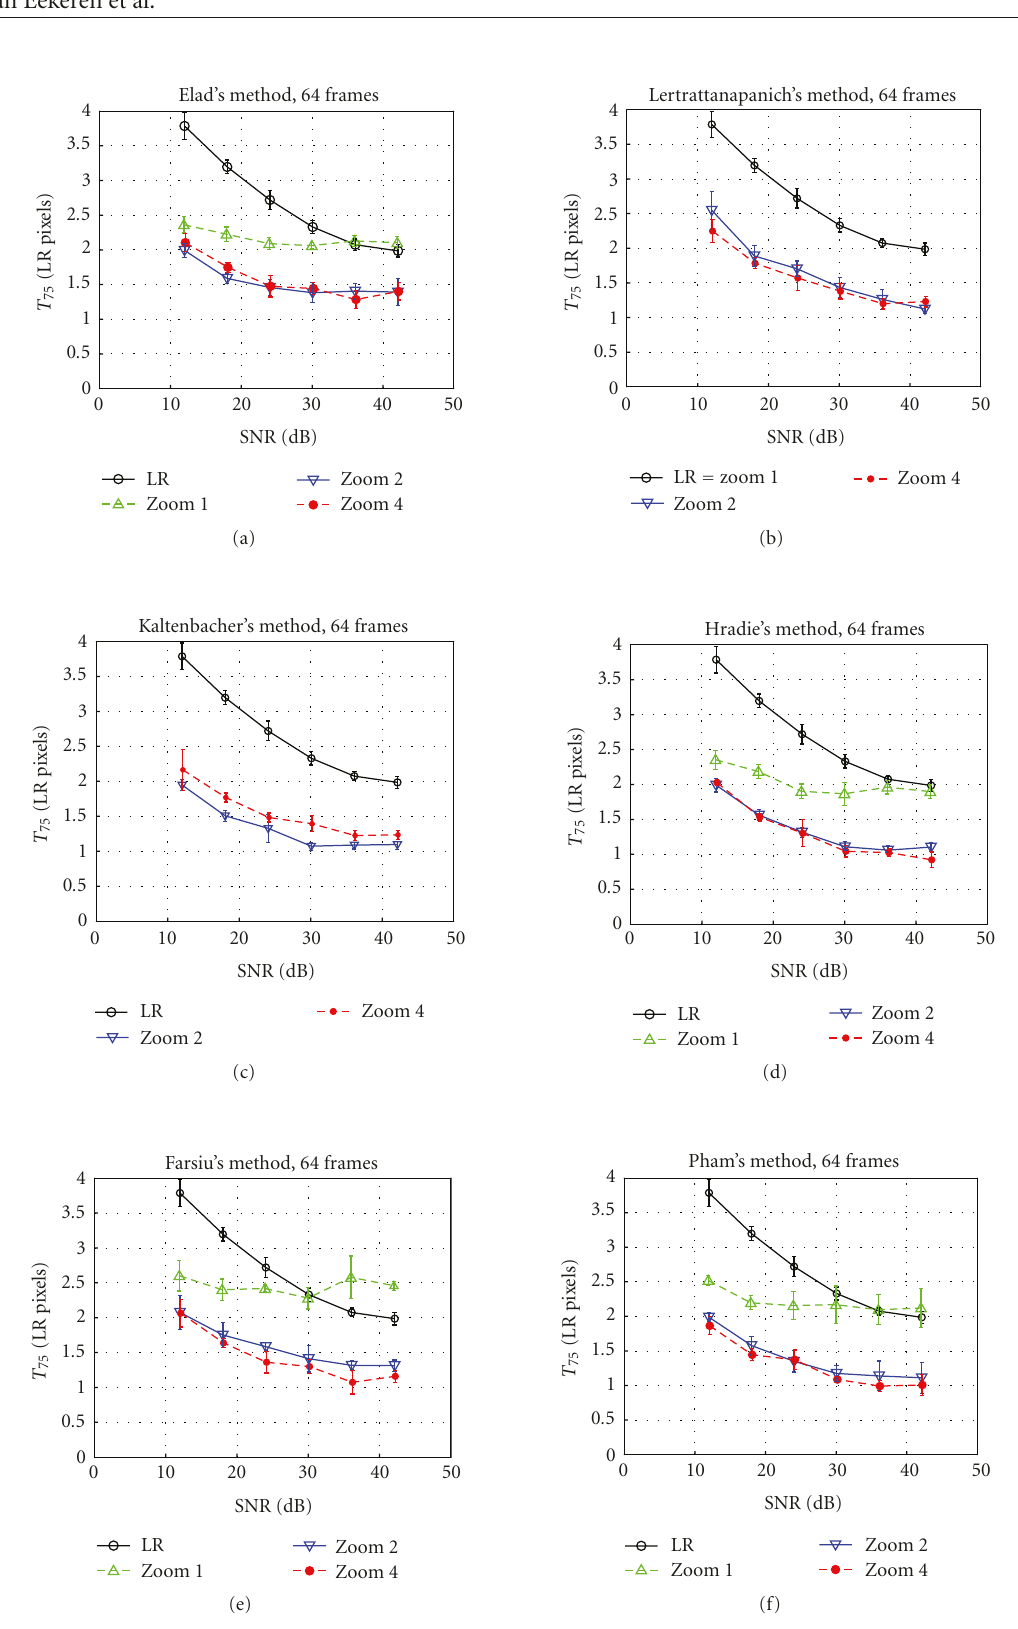
Figure 10: Performance measurements on simulated LR data ( σ PSF = 0 . 2, ff = 100%, 64 frames), processed with di ff erent methods with optimized settings for zoom factors 1, 2, and 4. (a) Elad, (b) Lertrattanapanich, (c) Kaltenbacher (no zoom factor 1 results could be obtained with our implementation), (d) Hardie, (e) Farsiu, (f)